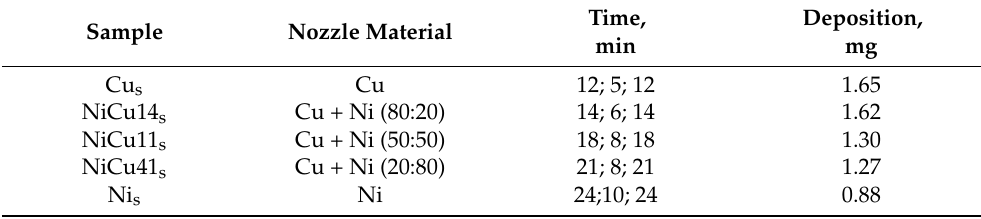
Table 9. Experimental conditions used for the preparation of Ni-Cu oxide catalysts (substrate temperature < 60 ◦ C; three layers deposited at pressure 2, 80, and 2 Pa), and the average amount of oxides deposited on a single